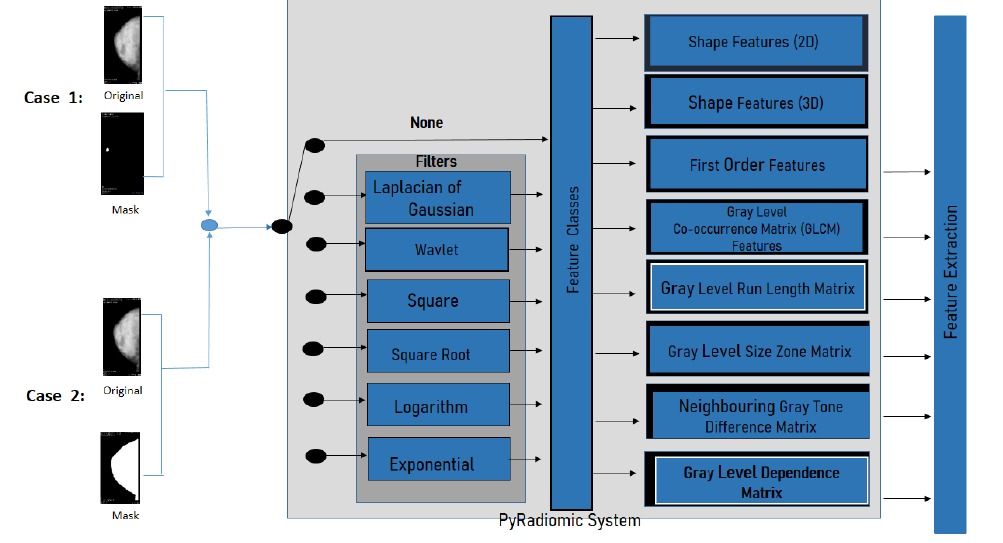
Figure 5. PyRadiomics System configuration for this